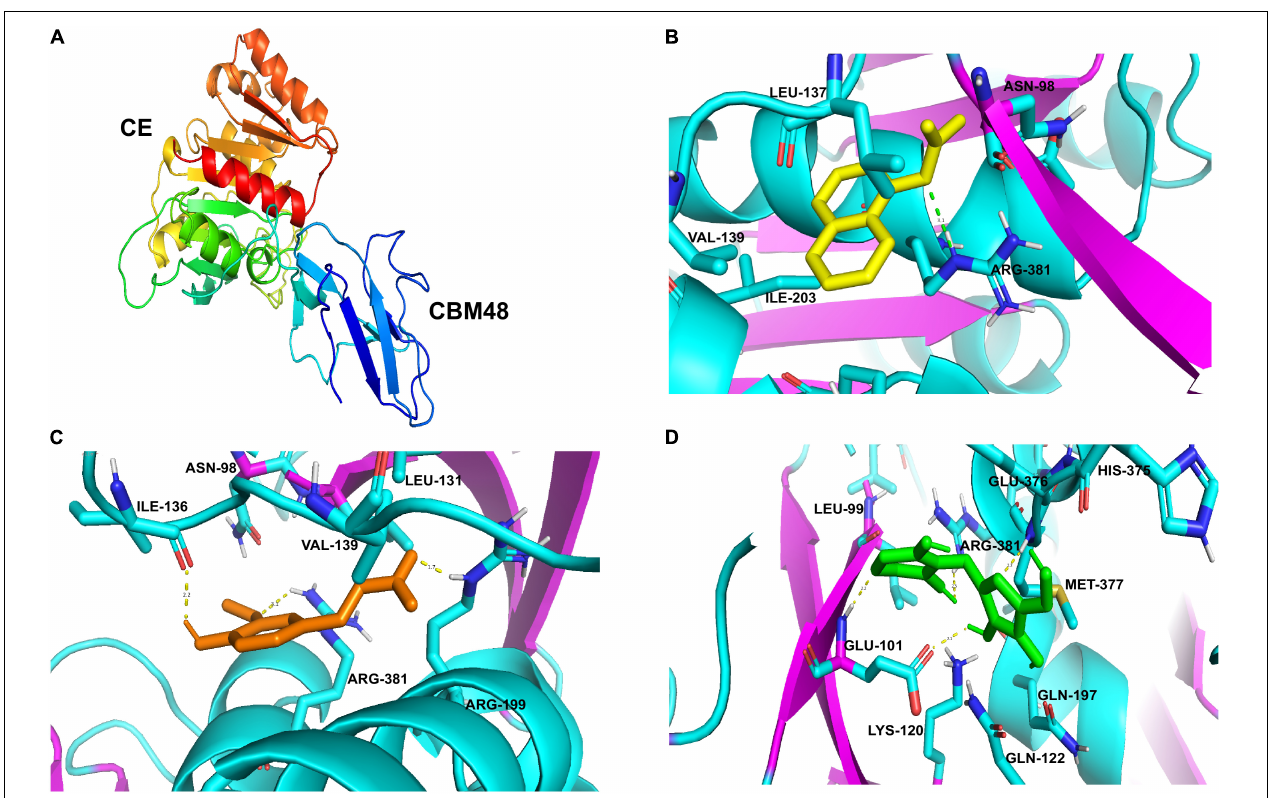
FIGURE 4 | Predicted docked interactions of R13 Fae protein from Rahnella sp. (A) The cartoon structure: CE and CBM48 domains. The arrows indicate β -sheet, helical and α -helices structures. Cartoon diagrams highlight the interaction with ligands (B) α -naphthyl-acetate, (C) ferulic acid, and (D) arabinoxylan. TABLE 3 | Interaction, binding energy, and interaction residues of ligands with R13 Fae. Substrate α -nafthyl-acetate Ferulic acid Arabinoxylan Amylopectin Amylose Interaction Negative and Negative Frequent Negative Frequent frequent Binding energy (kJ/mol − 1 ) Interaction